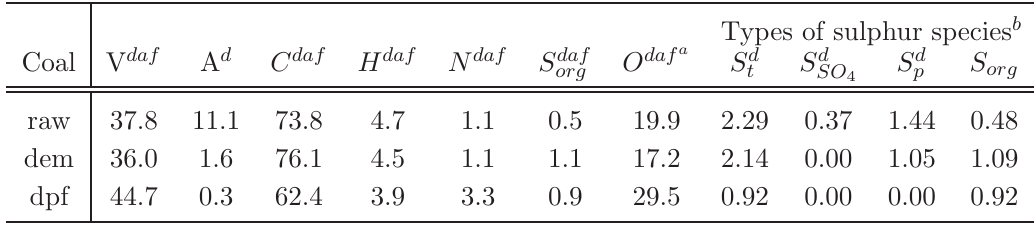
Table 1 Characteristics of raw, demineralised, and demineralised pyrite-free coal [wt %]